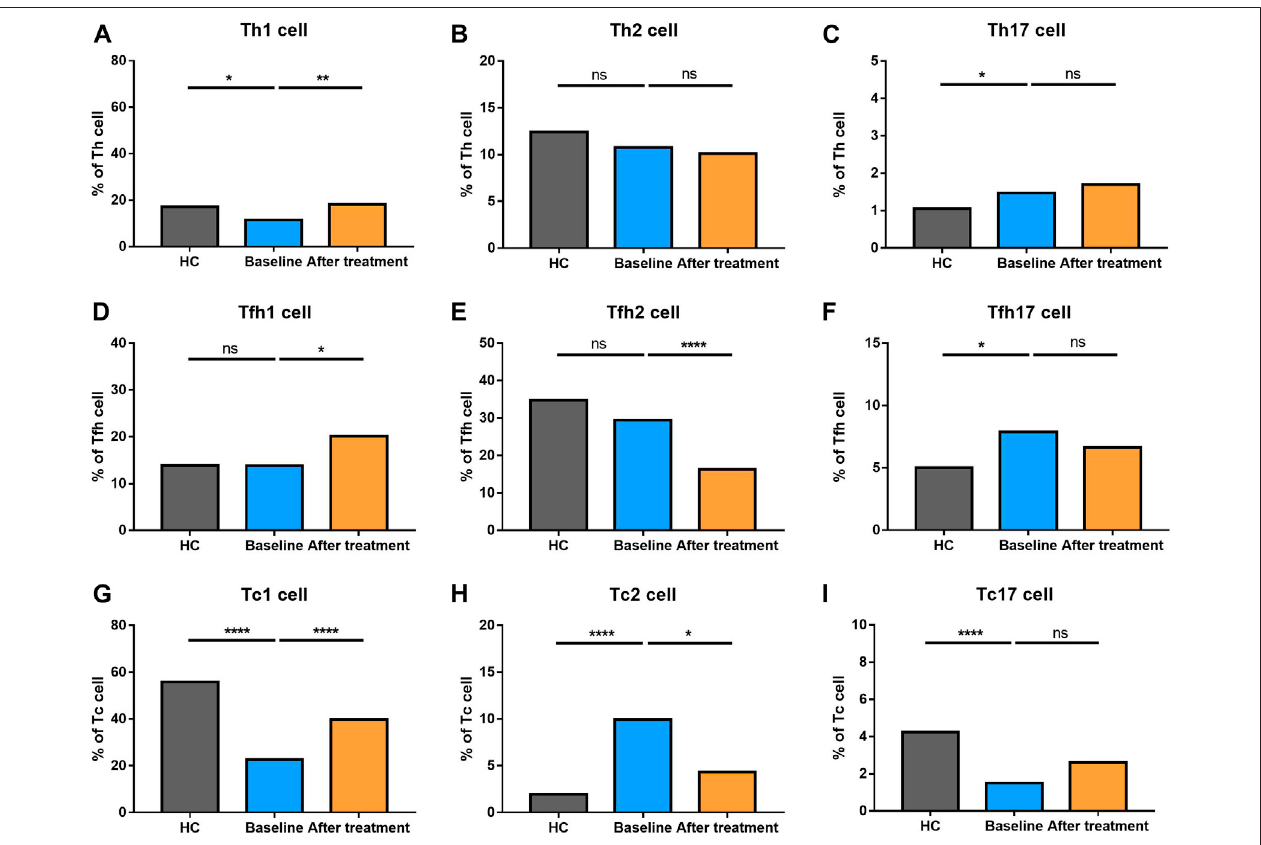
FIGURE5| AlteredexpressionofTh,Tfh,andTccellsubsetsinASpatientsaftertreatedwithsecukinumab.TheproportionofTh,Tfh,andTcsubsetsmeasuredby fl owcytometryatbaselineandafterreceivingsecukinumabinASpatients.Thcell,helperTcell;Tfhcell,follicularhelperTcell;Tccell,cytotoxicTcell;ns,notsigni fi cant;*, p < 0.05; **, p < 0.01; ***, p ≤ 0.001; ****, p < 0.0001.